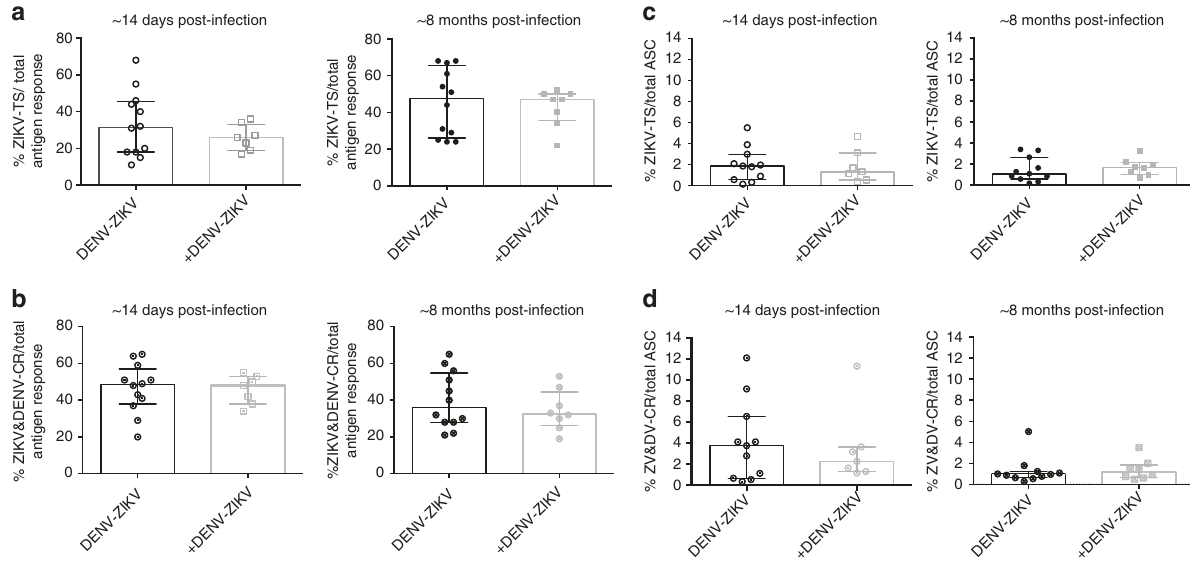
Fig. 4 The number of previous DENV exposures does not affect type-speci fi c and cross-reactive MBC responses. Comparison of ZIKV type-speci fi c and ZIKV and DENV cross-reactive responses in ZIKV-infected patients with one (DENV-ZIKV) or more than one ( + DENV-ZIKV) prior DENV exposure at ~14 days and ~8 months postinfection. a Proportion of ZIKV type-speci fi city (TS) of DENV-ZIKV and + DENV-ZIKV subjects over total antigen response. b Proportion of ZIKV & DENV cross-reactivity (CR) of DENV-ZIKV and + DENV-ZIKV subjects over total antigen response. c Frequency of type-speci fi c responses of DENV-ZIKV and + DENV-ZIKV subjects over total activated MBCs (ASC). d Frequency of cross-reactive responses of DENV-ZIKV and + DENV-ZIKV subjects over total ASC. The median and IQR are shown for all graphs. Statistical analysis was performed by Mann – Whitney test comparing DENV-ZIKV and + DENV-ZIKV at each time point, but no signi fi cant differences were found among different groups. DENV-naïve, n = 11; DENV-ZIKV, n = 12; + DENV-ZIKV, n = 7 at ~14 days postinfection (one PBMC sample was not viable), and n = 8 at ~8 months response was de fi ned as the post-DENV depletion value divided by the value in control bovine serum albumin (BSA)-depleted serum. The difference between the ZIKV type-speci fi c response and total response is designated the ZIKV and DENV cross- reactive antibody response (Fig. 5b). In serum, the anti-ZIKV